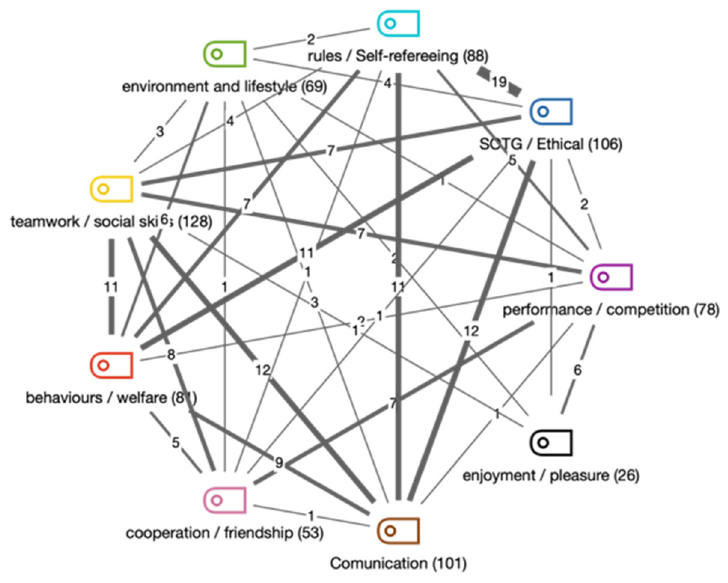
Figure 2. Conceptual map of interconnection between emerged categories. Because UF is a self-refereeing sport, communication between players from different cultures is normal and depends on equivalence in thoughts and situations and not